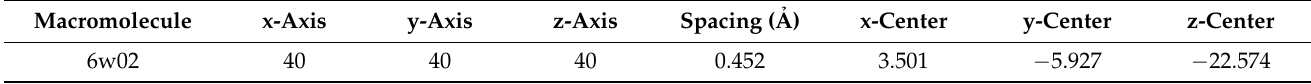
Table 1. Grid coordinates used for docking of ARP enzyme.